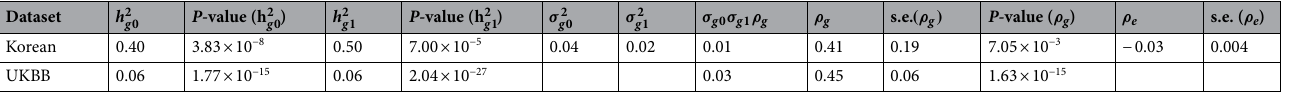
Table 4. Heritability and genetic correlation of asthma and COPD disease. g 0 : Asthma, g 1 :